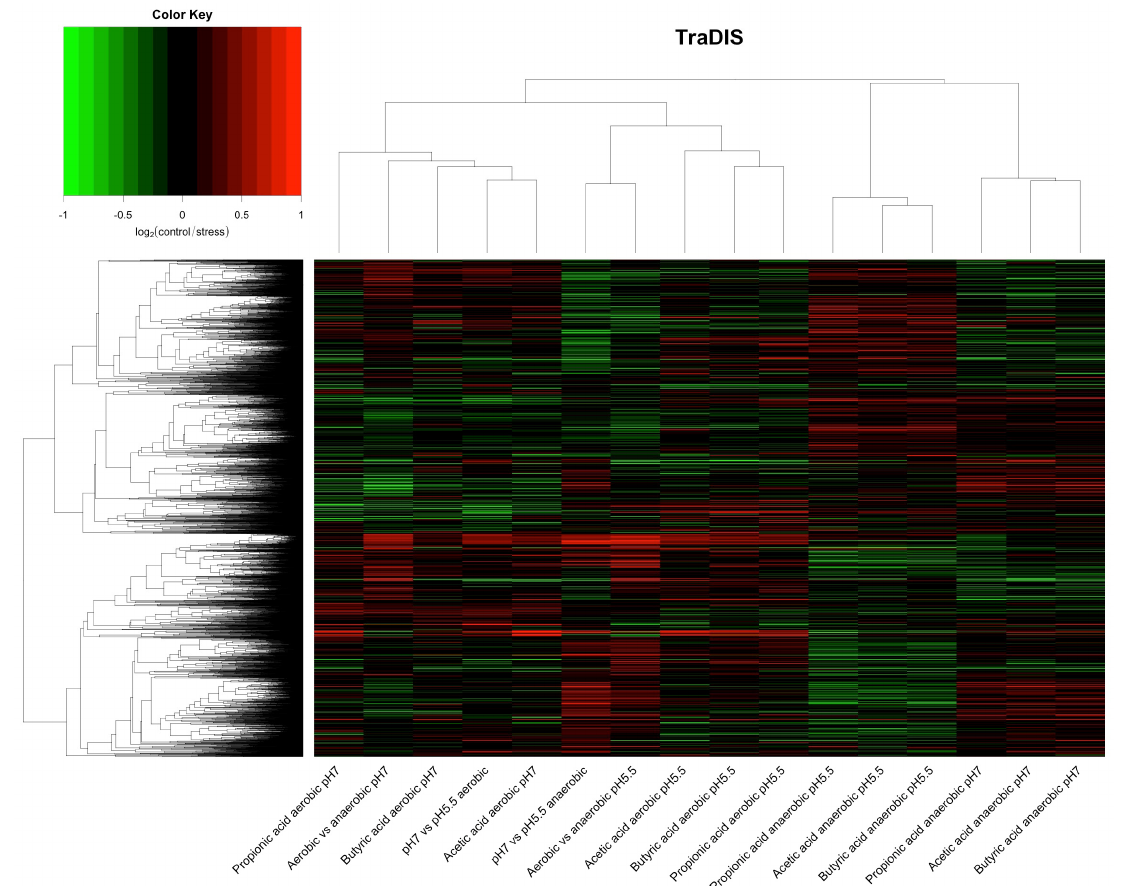
Figure 4. Cluster analysis of TraDIS data. TraDIS data were calculated as log 2 fold change (control/stress) for all conditions. Values for all genes with a TraDIS score were clustered using as described in Materials and Methods. Conditions are shown on the x axis. Red and green indicate, respectively, positive or negative contribution to fitness under the stress compared to the